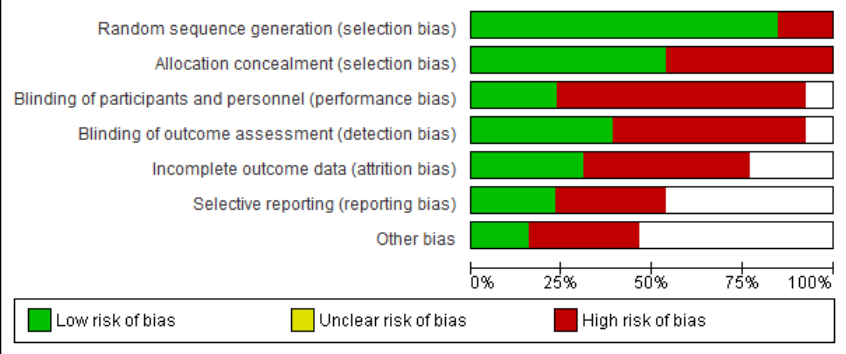
Figure 2. Risk of bias graph.